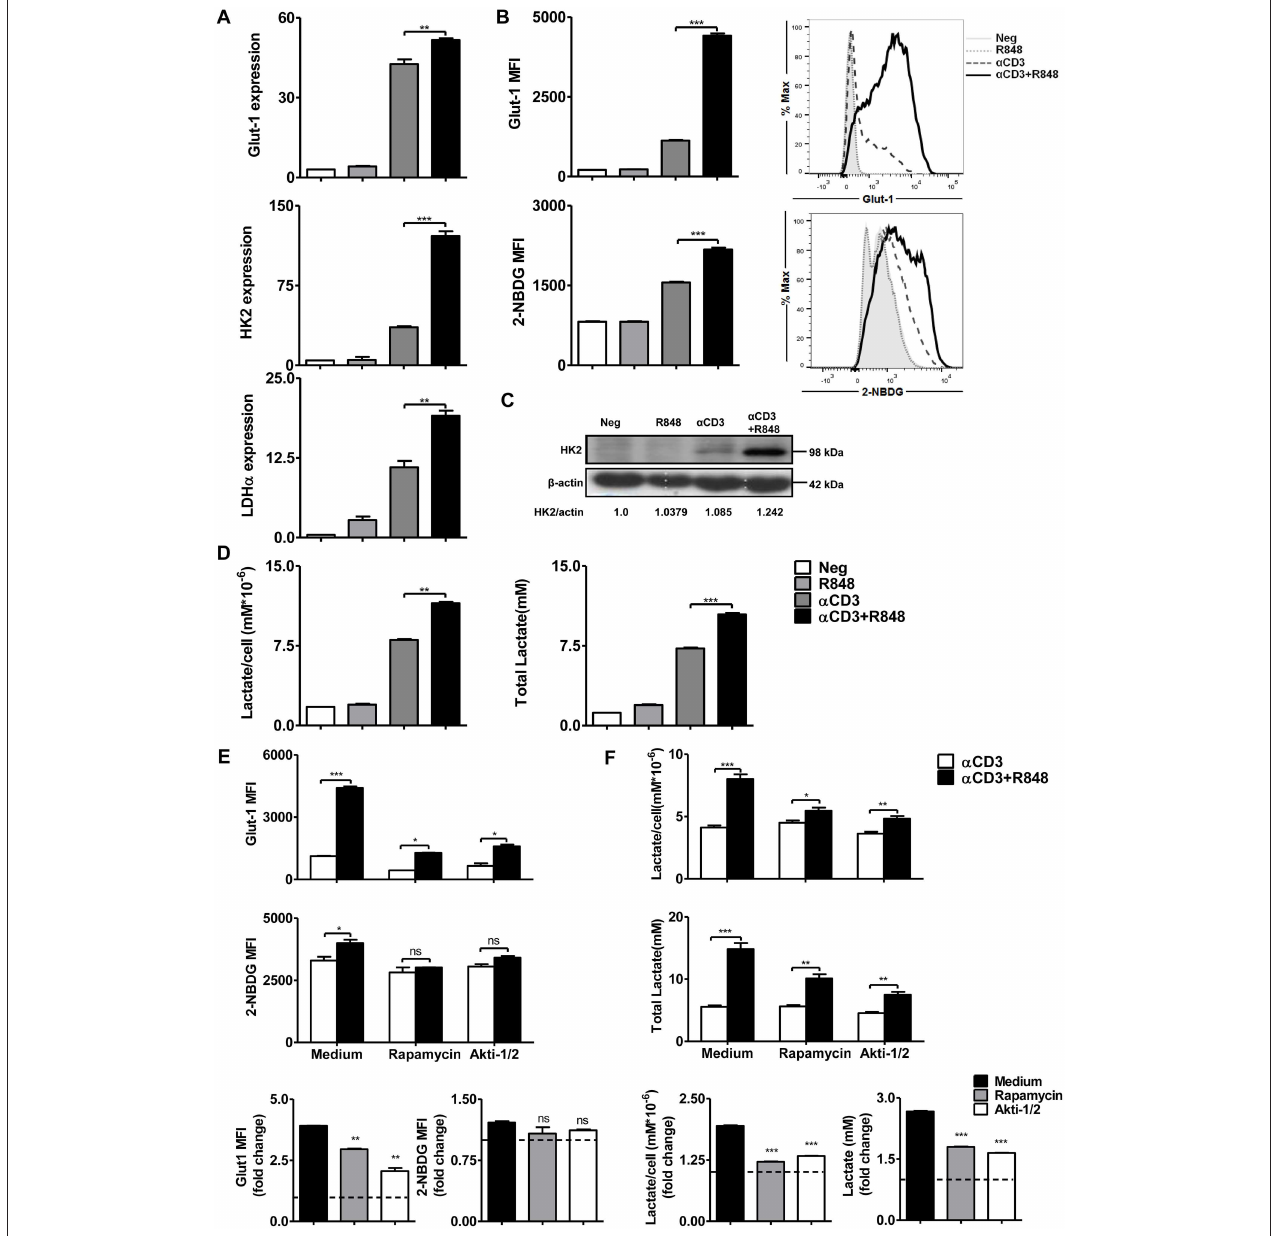
FIGURE 4 | TLR7 agonists improve glycolytic metabolism via mTOR signaling in CD8 + T cells. Purified CD8 + T cells were stimulated with an α CD3 antibody (5 µ g/mL) with or without R848 (10 µ g/mL) in the presence of rapamycin (2 µ M) or Akti-1/2 (1 µ M). (A) The expression of the glycolysis-related genes Glut-1 , HK2 , and LDH α was measured by real-time RT-PCR 24h after stimulation. (B) The Glut-1 expression was detected by flow cytometry and uptake of glucose was measured by detecting MFI of the glucose analog 2-NBDG in CD8 + T cells 48h after stimulation. (C) HK2 expression was detected by western blotting 24h after stimulation. (D) Lactate production was measured by a specific enzyme assay after stimulation for 24h. (E,F) Glycolysis in CD8 + T cells was measured by detecting MFI of Glut-1 and 2-NBDG and lactate production after treating the cells with rapamycin or Akti-1/2 for 48h. The Glut-1 expression, 2-NBDG uptake, and lactate production in the α CD3 + R848 stimulated cells were expressed as fold changes compared to the α CD3 stimulated cells after the corresponding treatment with rapamycin/Akti-1/2. Data are representative of three independent experiments. All data are presented as mean ± SD. The statistical relevance was determined by One-way ANOVA (A,B,D) or Two-way ANOVA (E,F) : * p < 0.05; ** p < 0.01; *** p < 0.001; ns, not significant.